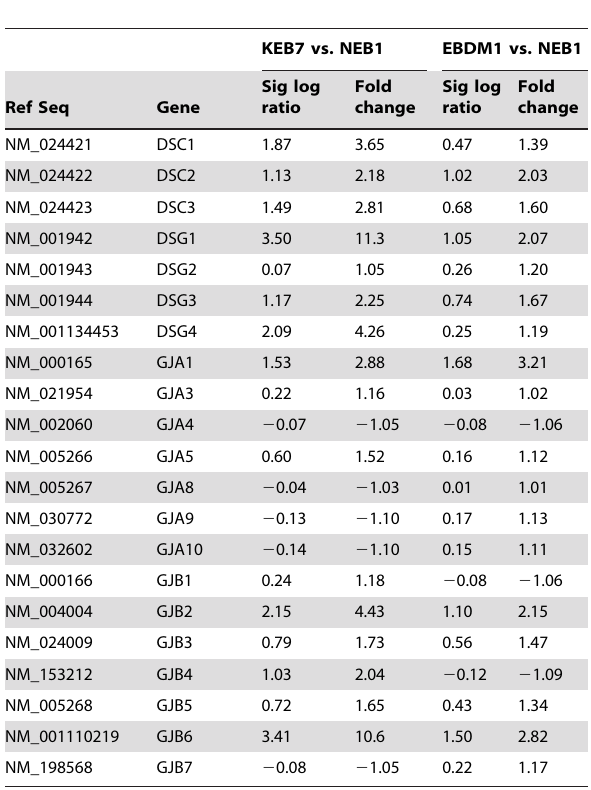
Table 6. Microarray analysis of junction protein genes.